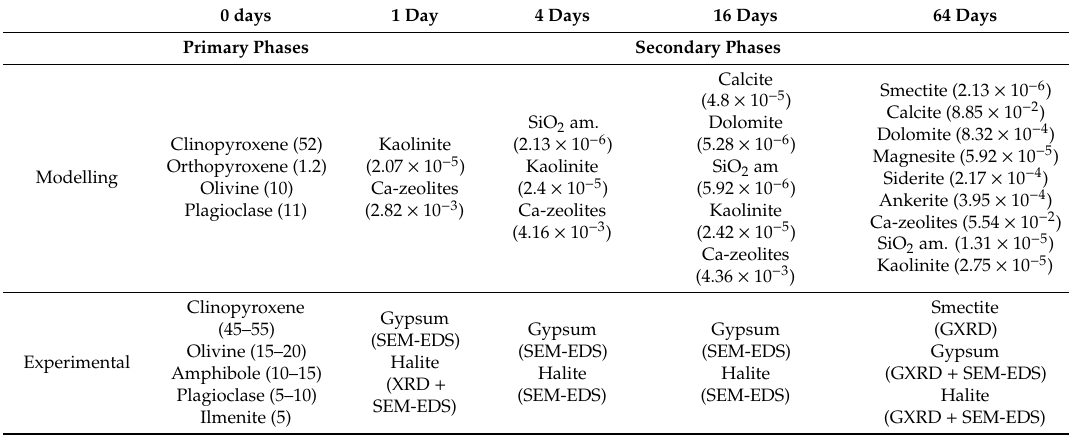
Table 9. Comparative summary of modelled and experimental mineral phases from cumulate gabbro (GXRD: grazing incidence geometry XRD; phases expressed as vol